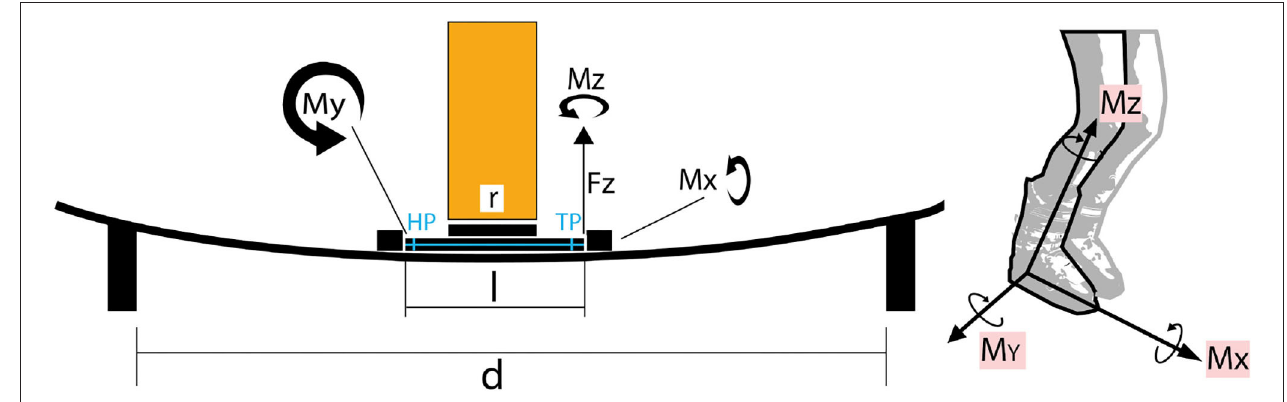
FIGURE 1 | Definition of Cartesian coordinates and of the acting forces and torques, geometry of the test setup: length of ski boot replacing device l , length of connection flange r , distance between mounting support d , toe piece TP , heel port HP , force in positive z-direction F z , torques about x-, y-, and z-axis M x , M y , and M z , respectively.